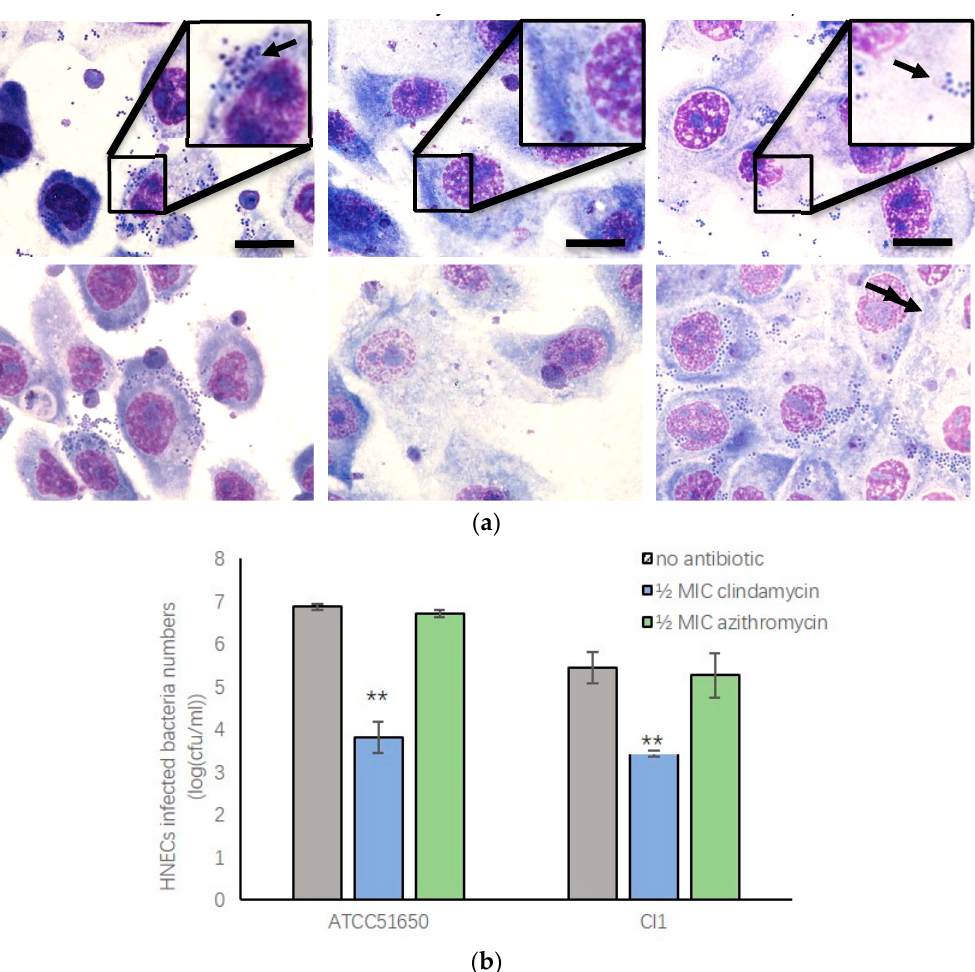
Figure 6. ½ MIC clindamycin treatment of S. aureus reduced intracellular infection of HNECs. a : Giemsa staining of HNECs with different antibiotic treated S. aureus ATCC51650 and CI1 showing the presence of intracellular cocci (arrow). b : Colony Forming Units (log CFU/mL) of intracellular S. aureus ATCC 51560 and CI1 in HNECs. ** p < 0.01, one-way ANOVA followed LSD post hoc comparison. Table 4. S. aureus intracellular infection rate. Cells were Giemsa stained and % of HNECs infected by S. aureus quantified and the average of three independent infection rates expressed as mean ± SEM. Compared with no antibiotic treatment, ½ MIC clindamycin significantly reduced intracellular infection rate of ATCC 51650 and CI1 (** p < 0.01).